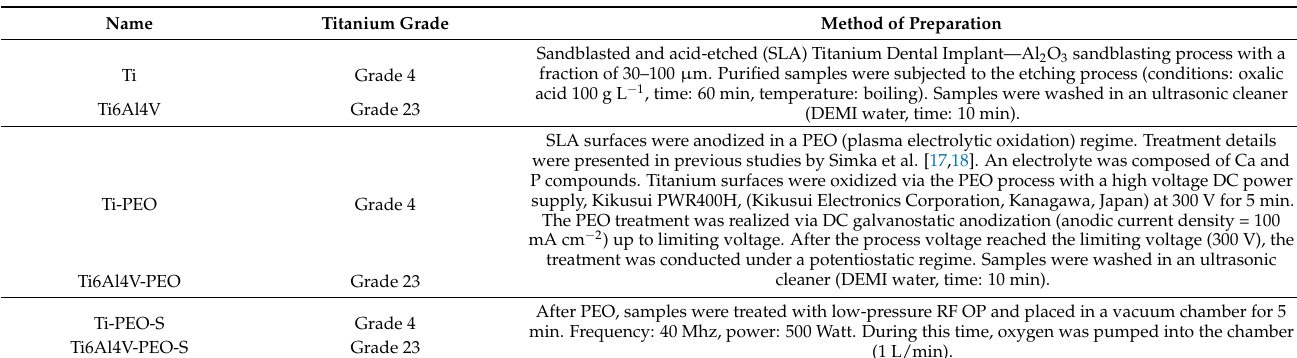
Table 9. Preparation of the titanium